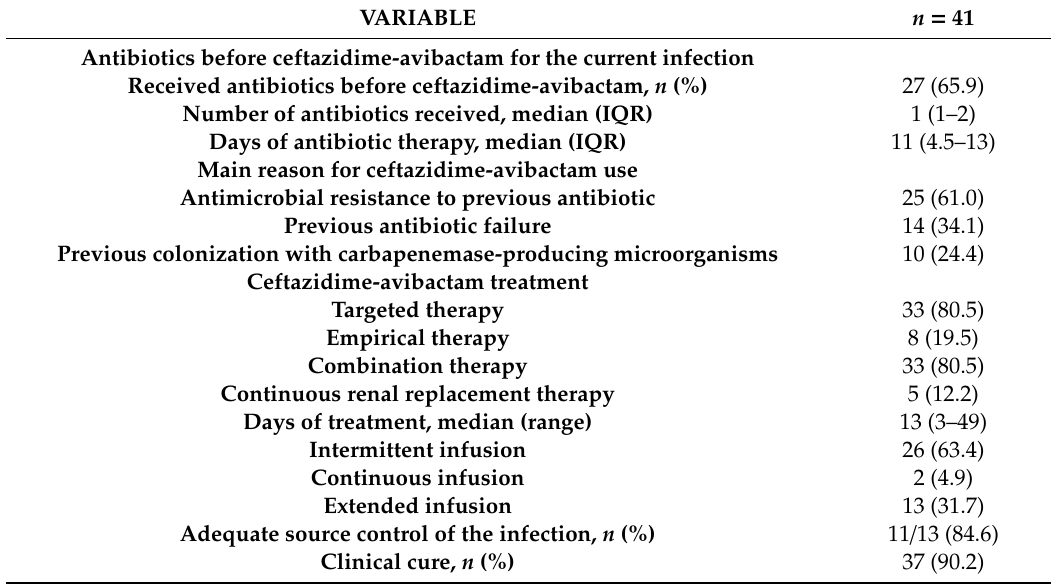
Table 4. Previous treatment characteristics and ceftazidime-avibactam treatment information. VARIABLE n =